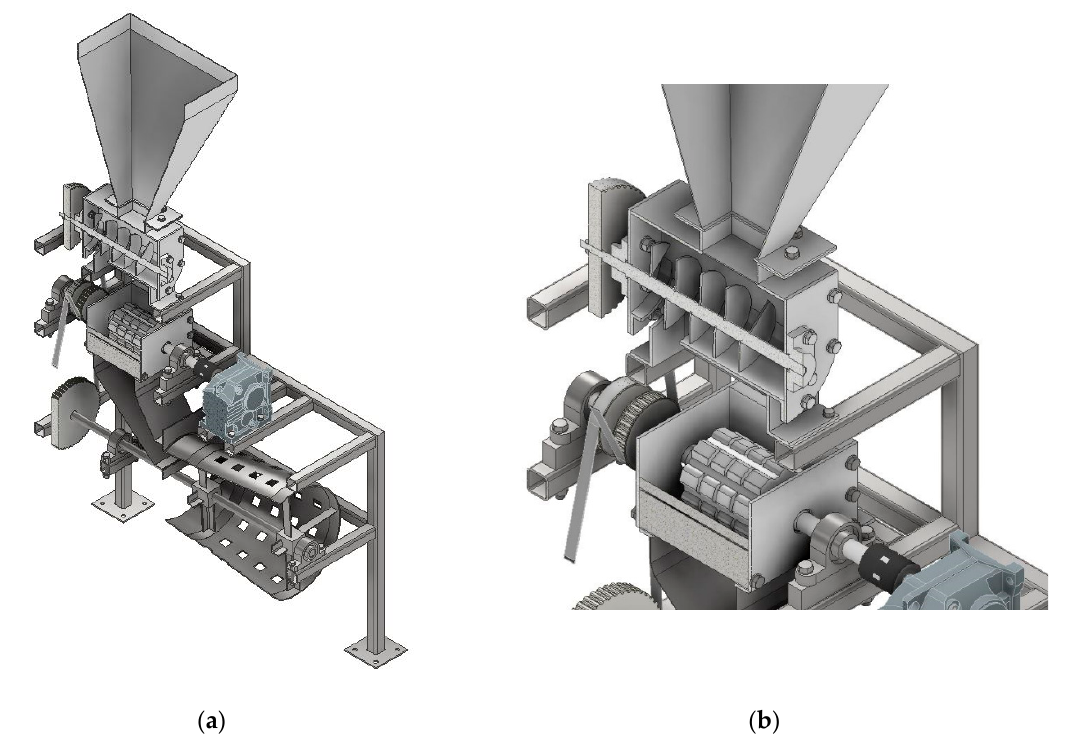
Figure 14. ( a ) Section of the shell cracking machine corresponds to the fruits flow; ( b ) Dosify and cracking of fruits section.